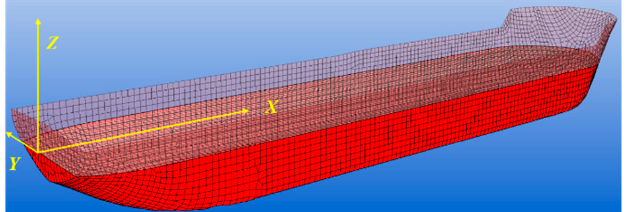
Figure 3. Ship surface model.